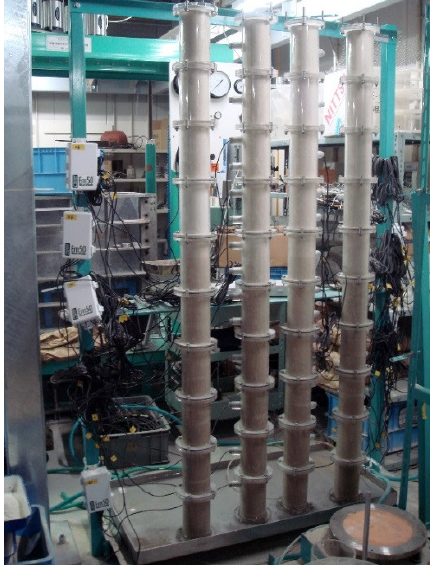
Figure 3. Setup of the capillary rise in the layered soil.